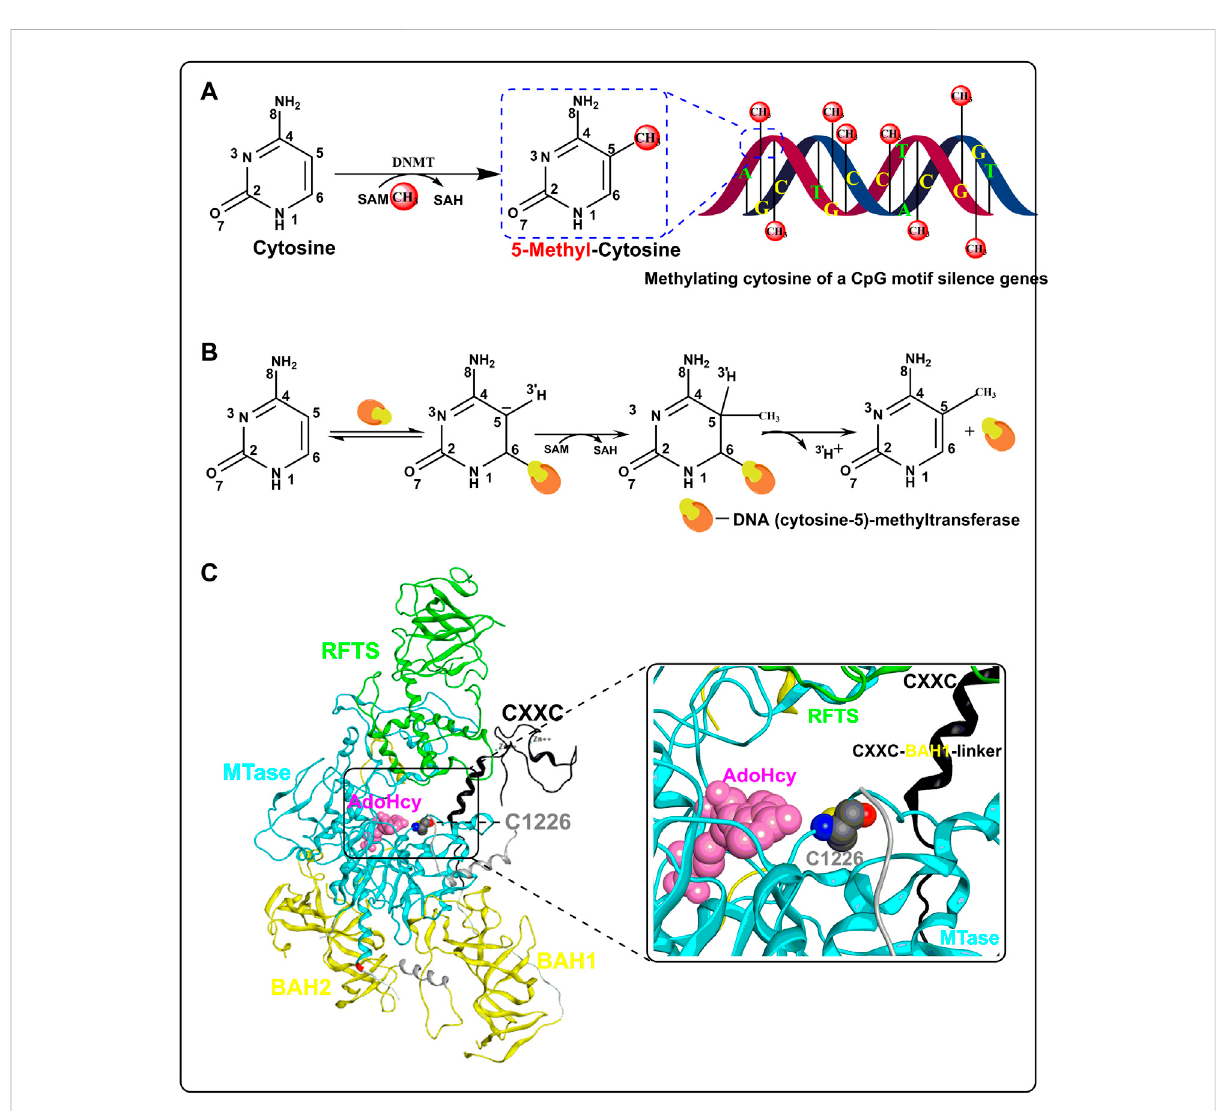
FIGURE 1 Process andmechanism ofDNAmethylation. (A) The overall processofCpG methylation byDNMT. (B) MechanismofDNAmethylationinDNA (cytosine-5)-methyltransferase. (C) Crystal structure of human DNA methyltransferase 1 with AdoHcy (PBD code: 4WXX). The RFTS, CXXC, MTase, and BAH domains are colored in green, black, light blue, and yellow, respectively. SAH is colored in pink and residue C1226 is colored in